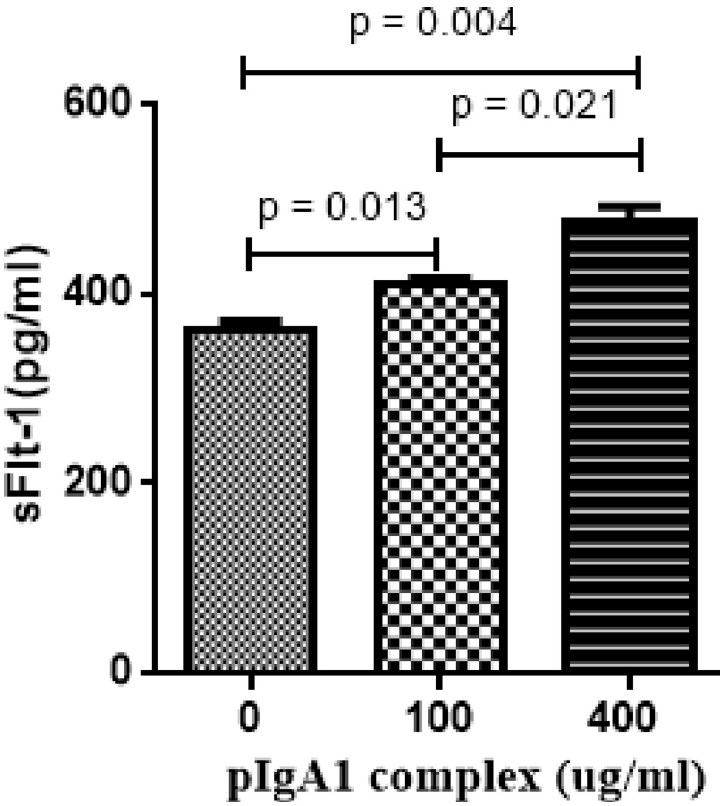
Fig 1. The sFlt-1 expression was upregulated by pIgA1 complex in the supernatant of HUVECs. The HUVECs were treated with pIgA1 complex. The histogram showed that sFlt-1 expression was increased significantly by pIgA1 complex derived from IgAN patients in a concentration-dependent manner. Results are the means ± standard deviation of three independent experiments. Statistically significant at p < 0.05 level vs. without pIgA1-treatment